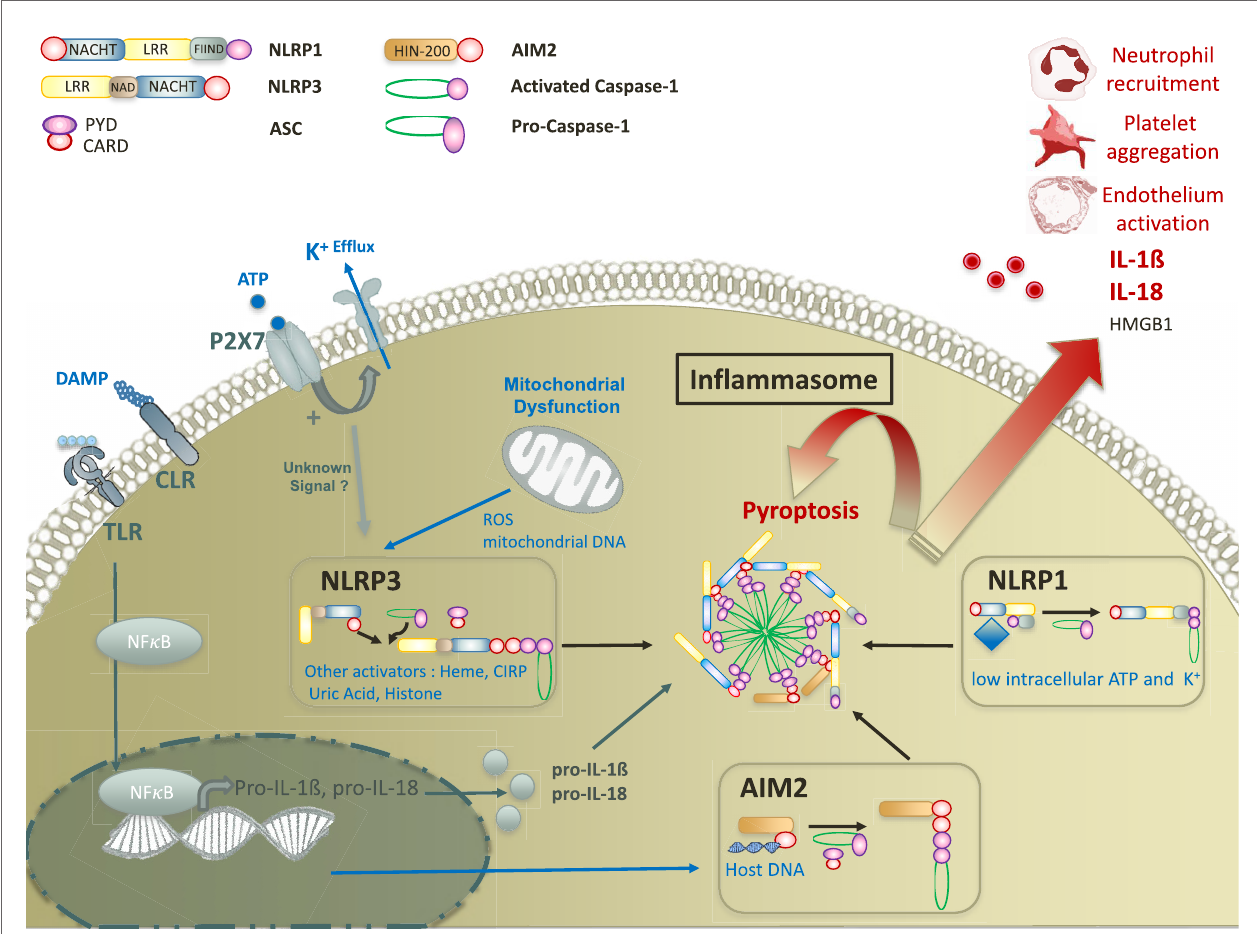
FiGURe 1 | Molecular mechanisms of damage-associated molecular pattern mediated inflammasome activation. Inflammasome activation requires two signals. The first signal ultimately leads to the translocation of NF κ B transcription factor to promote the expression of pro IL-18 and pro-IL-1 β . The second signal is mediated by a nod-like receptor (NLRP3, AIM2, or NLRP1). Upon activation, NLR activates caspase-1 with or without recruitment of adaptor protein ASC. Activated caspase-1 leads to inflammasome formation and to the secretion of mature forms of IL-18 and IL-1 β , and the release of HMGB1. In addition, inflammasomes promote a specific pro-inflammatory cell death, called pyroptosis that contributes to tissue damage in various cellular subtypes. Abbreviations: CIRP, cold-inducible RNA- binding protein; CLR, C-type lectin receptor; ROS, reactive oxygen species; ATP, adenosine triphosphate; TLR, toll-like receptor; IL, interleukine; AIM, absent in melanoma; NF κ B, nuclear factor-kappa B; HMGB1, high mobility group box 1.